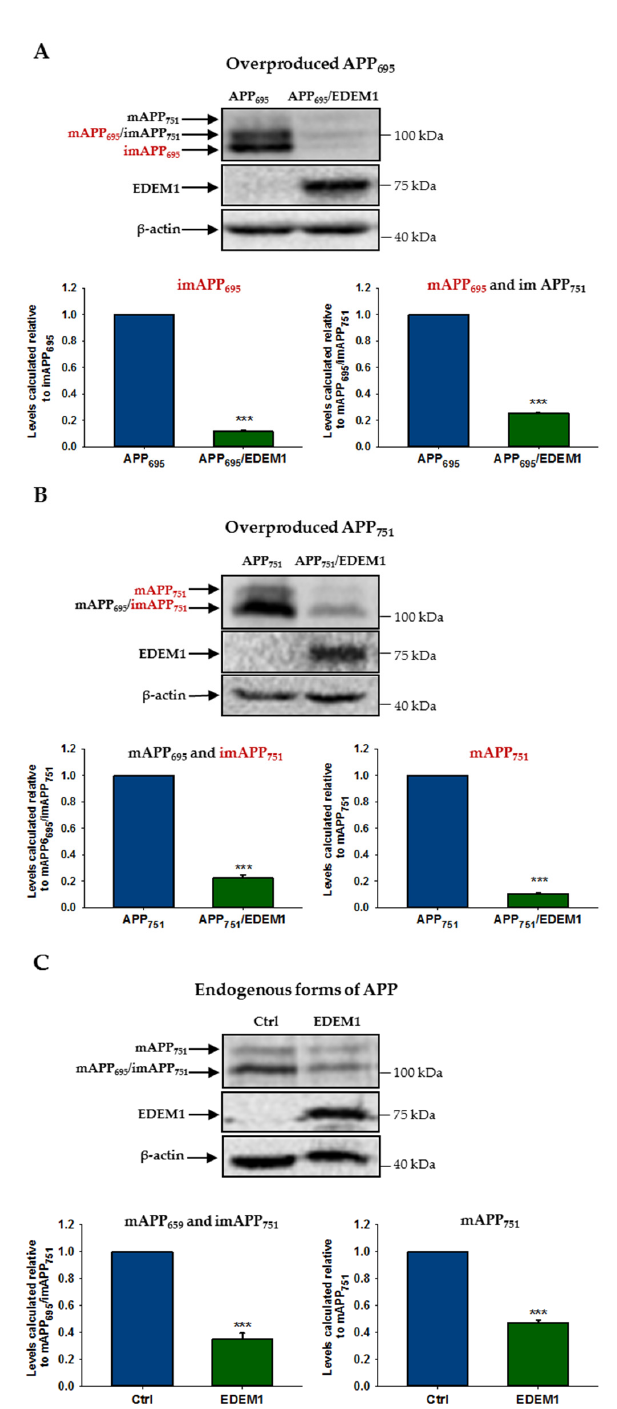
Figure 3. The level of various APP isoforms is reduced in HEK293 cells overexpressing EDEM1. Western blotting of APP, EDEM1 and actin in lysates of cells transfected with ( A ) APP 695, ( B ) APP 751, or ( C ) control cDNA with or without EDEM1 cotransfection (as indicated). Overexpressed, dominant forms present in ( A , B ) are indicated in red. Mature APP is abbreviated as mAPP, and immature APP as imAPP. Representative experiments are shown. Molecular mass markers are shown on the right side of the membranes. The levels of APP isoforms were quantified and are shown in the graphs. Values obtained for lysates of cells without EDEM1 overexpression are indicated as 1. Values representing EDEM1-transfected cells are plotted relative to 1. The values are expressed as mean ± SD, n ≥ 3, *** p < 0.001, Student’s t